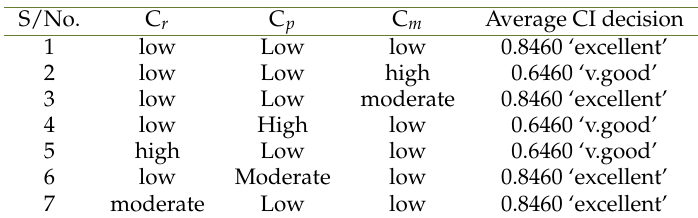
Table 5. Optimized cost implication decision